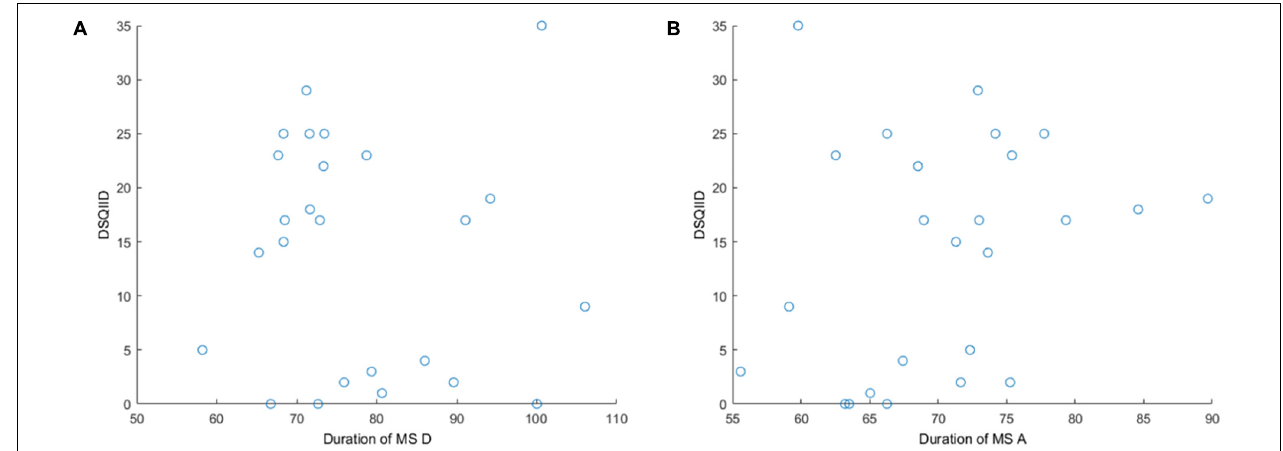
FIGURE 2 | Scatterplots for (A) DSQIID and the duration of microstate D, and (B) DSQIID and the duration of microstate A.